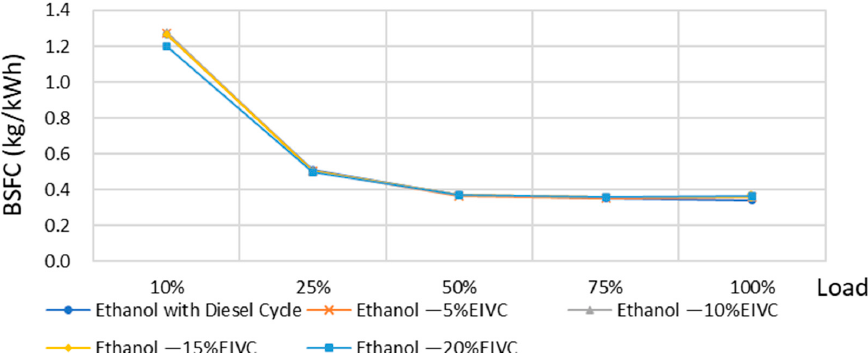
Figure 16. BSFC(g/kWh) of ethanol engine with EIVC Miller Cycle.